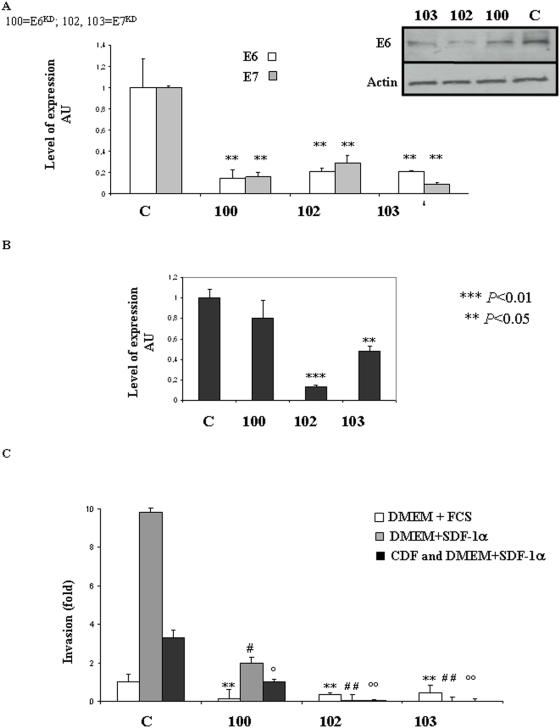
Silencing of E6 and E7 showed contribution of the oncoproteins to the pro-migratory phenotype of HeLa cells.(A) Quantitative RT-PCR analysis of E6 and E7 mRNA level and E6 protein expression in knock-down HeLa cells lines. E6 and E7 expression were respectively knocked-down using the pEBVsiRNA in 100, and 102, 103. Inhibition was statically significant P<0.04. (B) Quantitative RT-PCR analysis of CXCR4 mRNA level in clonesKD with CXCR4- specific probe. ***P<0.01 and **P<0.05. (C) Cell invasion was measured using a Matrigel assay in E6KD (100) and E7KD (102, 103) and compared to migration of a control HeLa clone (scrambled sequence). All Experiments were conducted in presence of Hygromycin (125 µg/mL) with DMEM+10% FCS; DMEM+SDF-1α (100 ng/mL); CDF and DMEM+SDF-1α (100 ng/mL). Three independent experiments with three chambers each time were performed. **P<0.05, for a statistically true difference, as compared to the control clone with DMEM+FCS. # P<0.05 and ## P<0.01 compared to the control clone with DMEM+SDF-1α. ° P<0.05 and °° P<0.01 compared to the control clone with CDF and DMEM+SDF-1α.